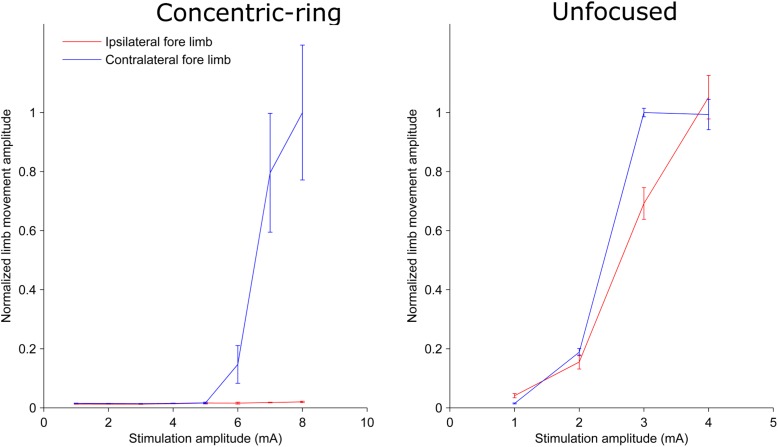
Plots from one rat showing the limb movement amplitude as a function of stimulation amplitude using a concentric-ring ECS (left panel) and unfocused ECS (right panel). Error bars represent the standard deviation. Note the difference in the stimulation amplitude scale between the two graphs. The concentric-ring electrode shows a selective stimulation of the contralateral fore limb (blue) with a threshold of 6 mA. On the other hand, the unfocused stimulation shows a movement in both contralateral (blue) and ipsilateral (red) fore limbs with a threshold of 2 mA. This indicates that the concentric-ring electrode provides stimulation of one specific target brain area which is not possible with an unfocused ECS electrode. However, because focused electrode produce a weaker electric field in the brain (see Figure 4), the concentric-ring ECS has a higher threshold than unfocused ECS.